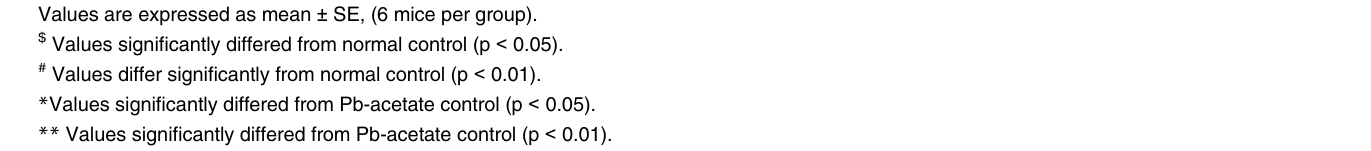
Values are expressed as mean ± SE, (6 mice per group). $ Values signi fi cantly differed from normal control (p < 0.05).